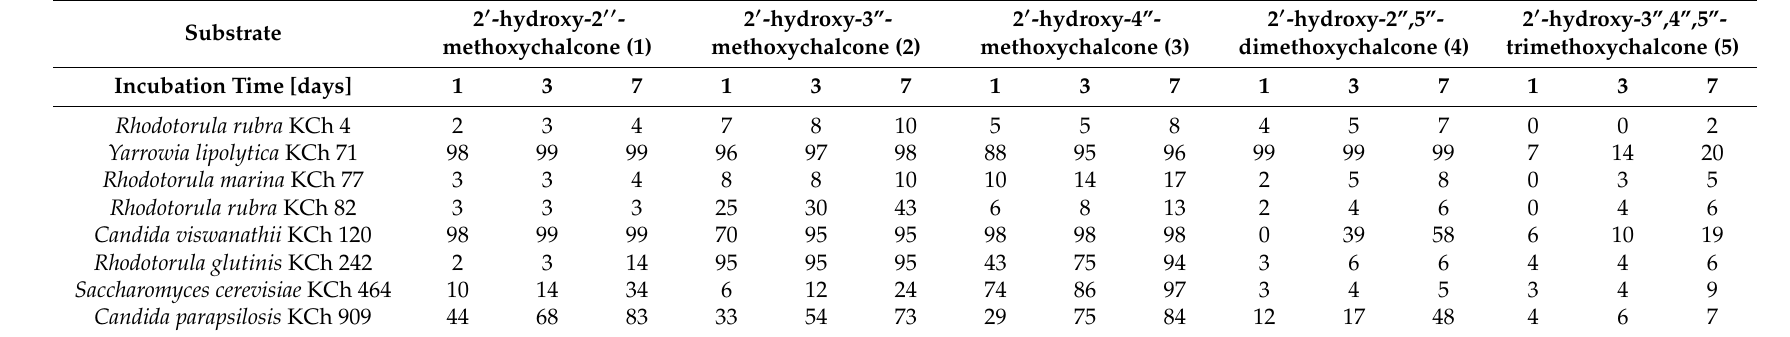
Table 2. Conversion [%] of the substrates in